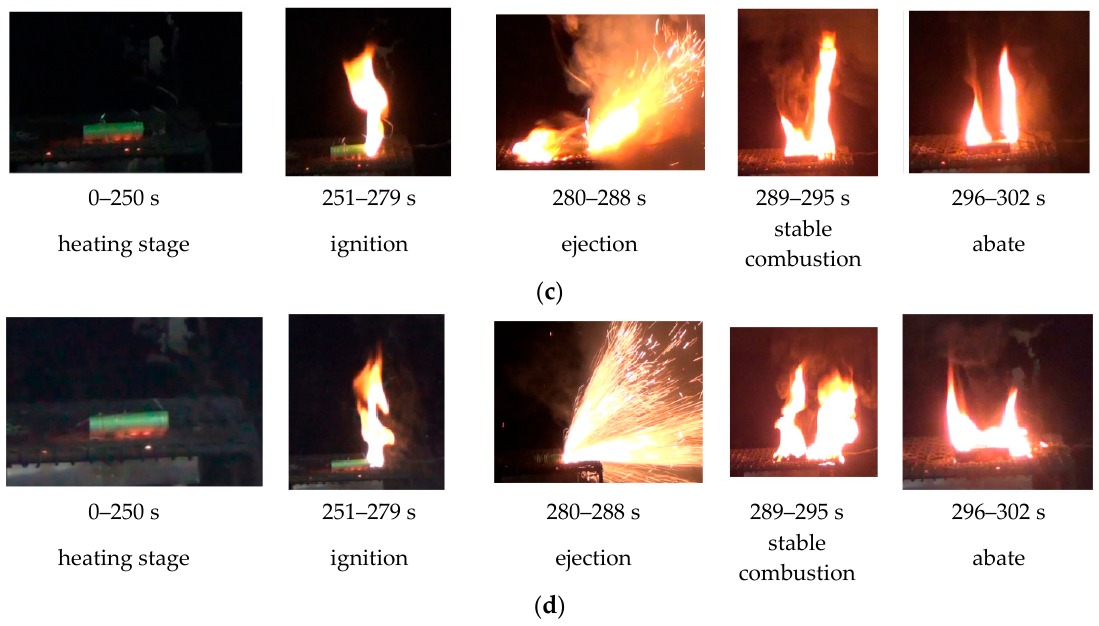
Figure 5. Burning process of LIBs in tests: ( a ) 4.2 V NMC; ( b ) 5.0 V NMC; ( c ) 4.2 V LFP; ( d ) 5.0 V LFP.